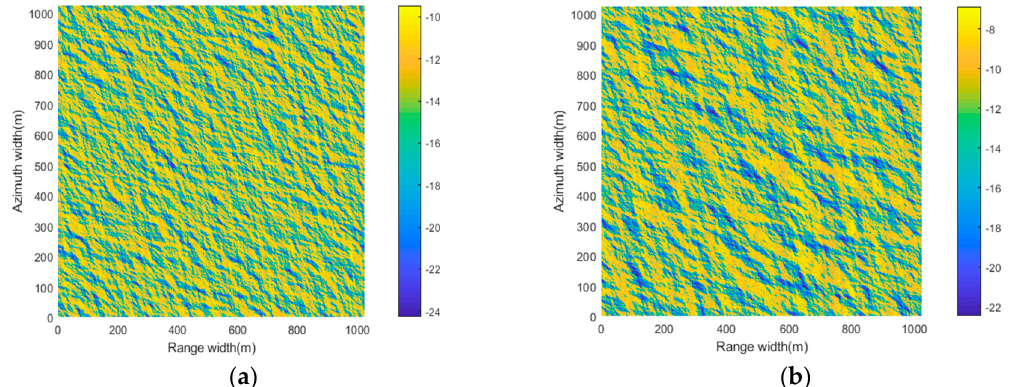
Figure 4. Ocean surface backscatter coefficient as follows: ( a ) wind speed of 10 m/s and ( b ) wind speed of 15 m/s. Table 1. System